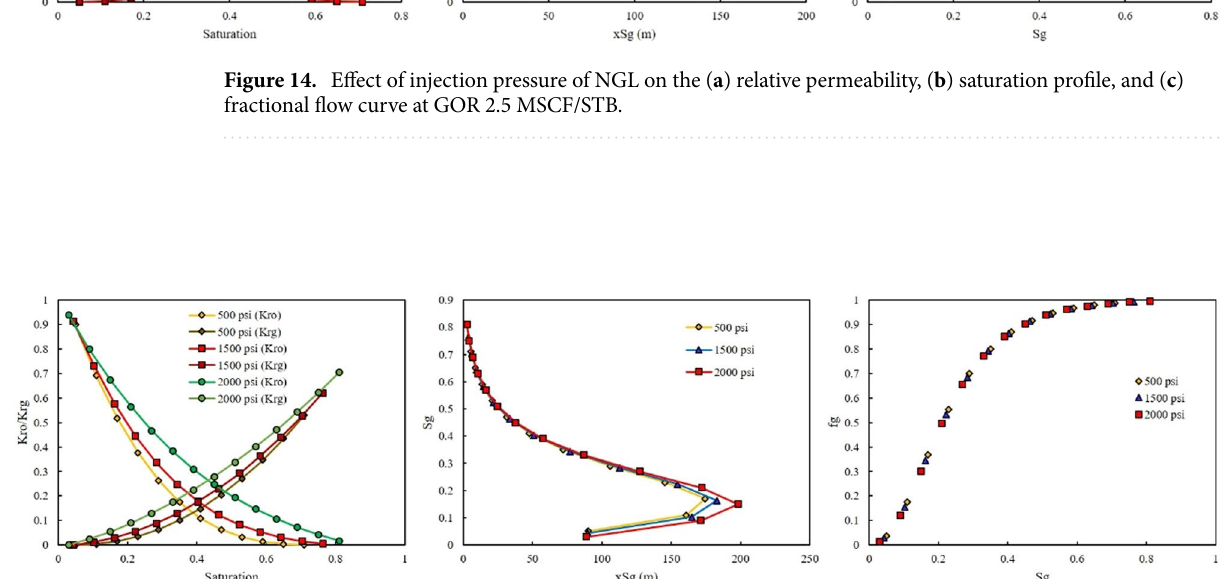
Figure 15. Effect of injection pressure of Naphtha on the ( a ) relative permeability, ( b ) saturation profile, and ( c ) fractional flow curve at GOR 2.5